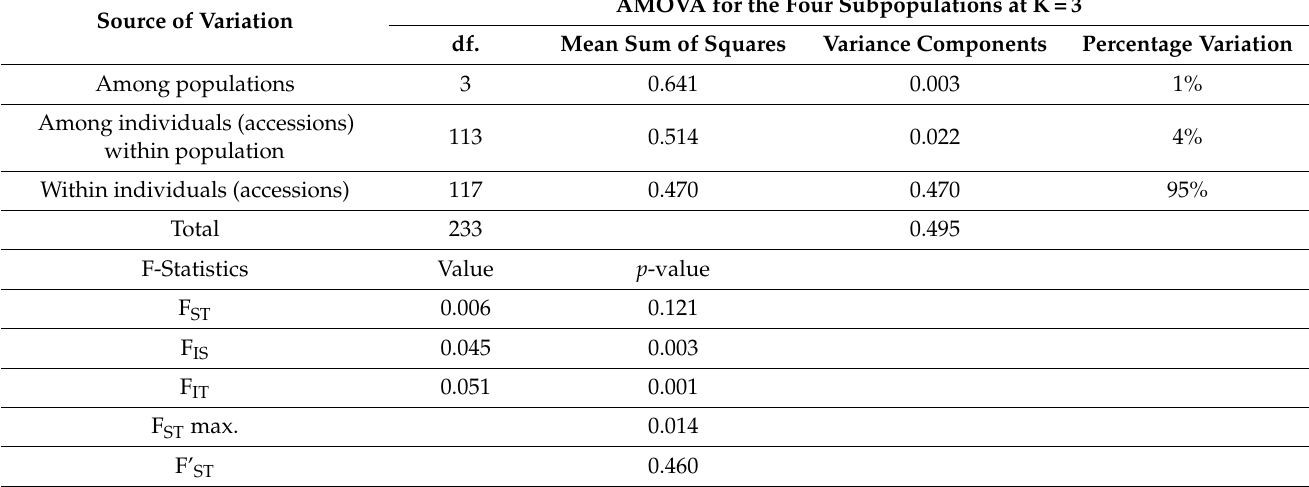
Table 3. Analysis of molecular variance (AMOVA) of the subpopulations of the panel population for antioxidant properties in 117 rice